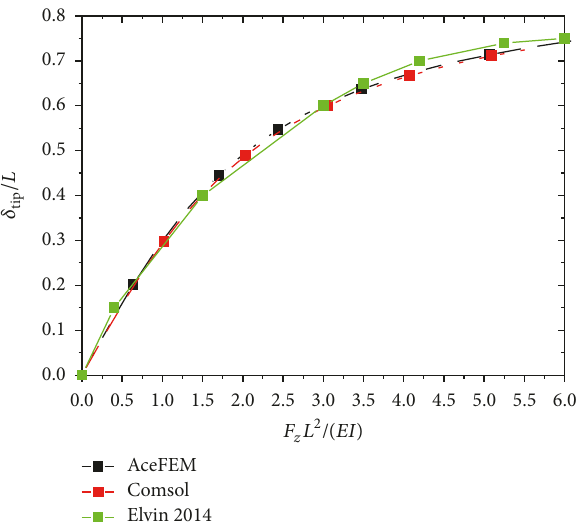
Figure 5: Vertical tip deflection of the cantilever unimorph: com- parison between FE solutions and experimental